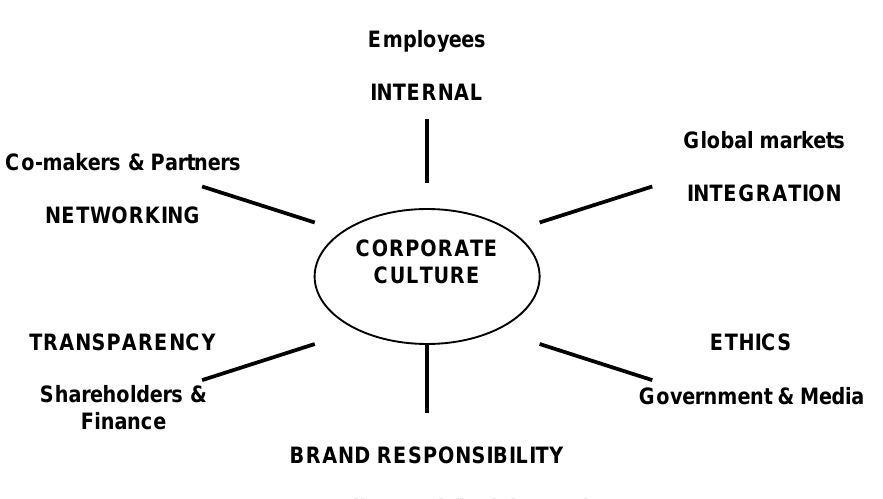
Figure 1: The Dimensions of Corporate